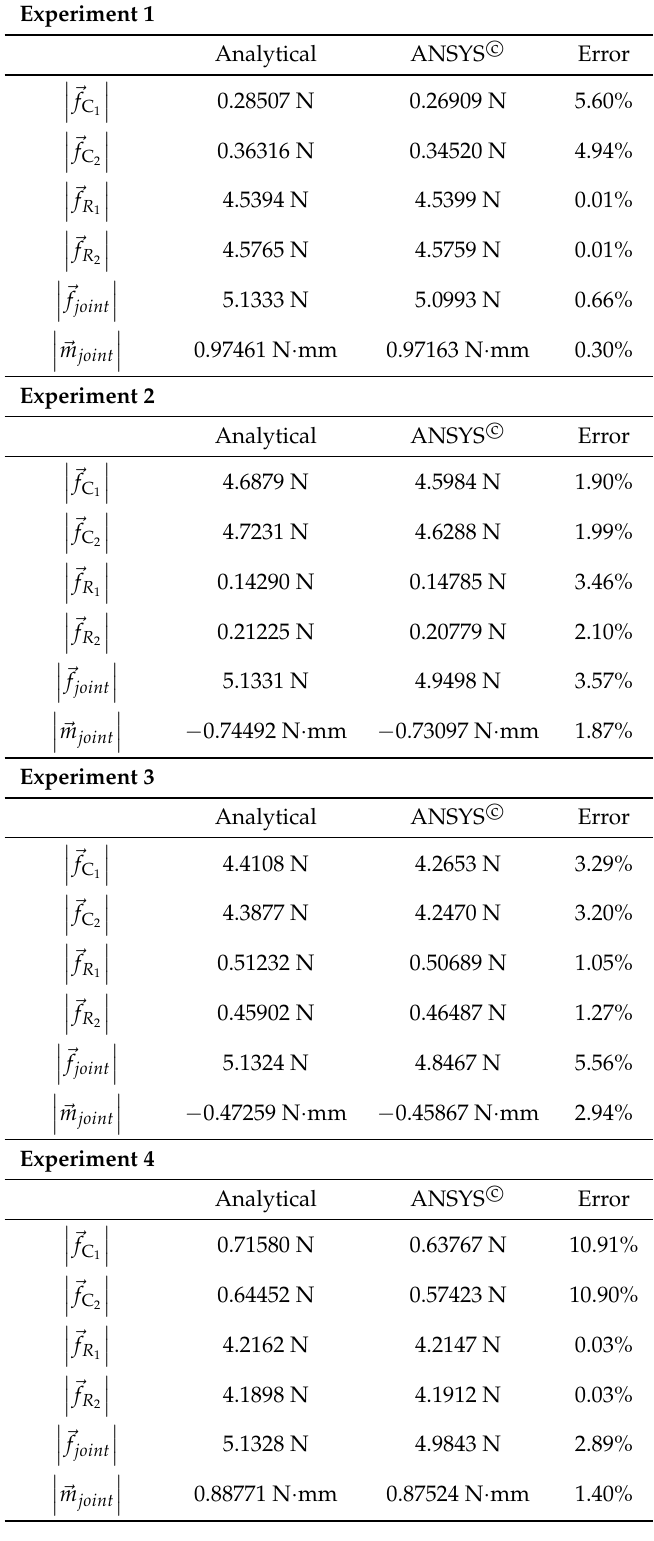
Table 5. Comparison between analytical and software